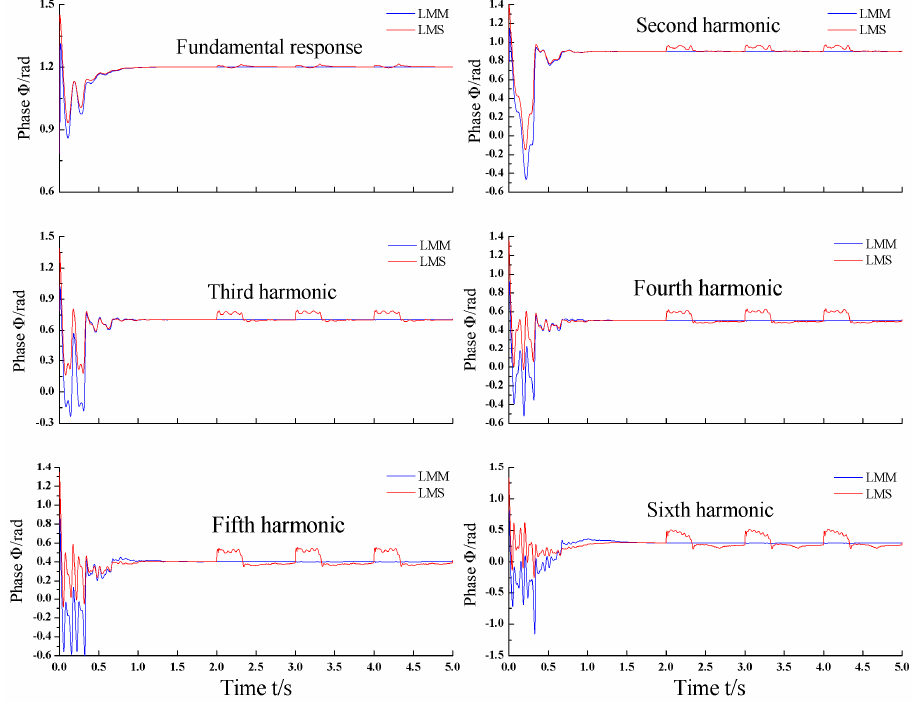
Figure 13. Estimation phases of simulation result (contaminated by impulse noise).